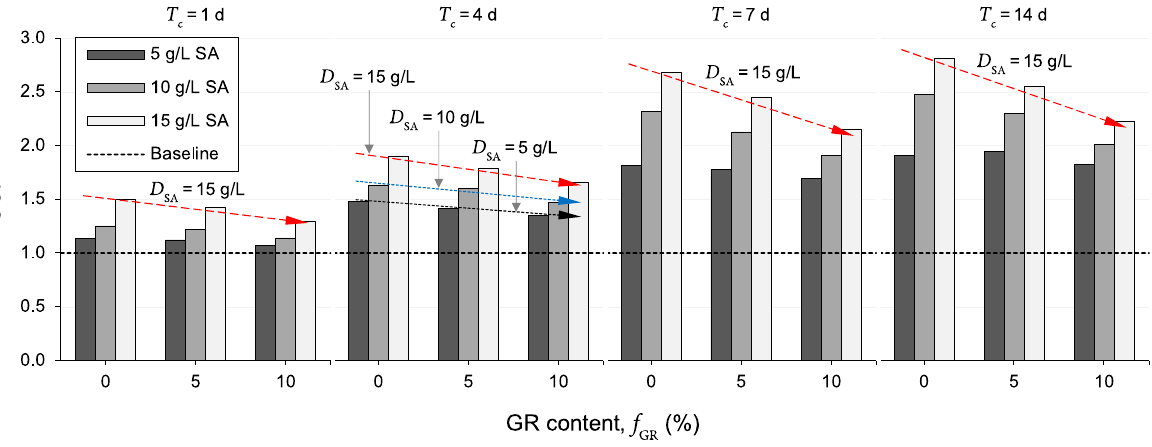
Figure 7. Variations of the SGF parameter—defined as the UCS ratio of an SA-treated sample to its non-treated counterpart—against GR content for the tested samples.